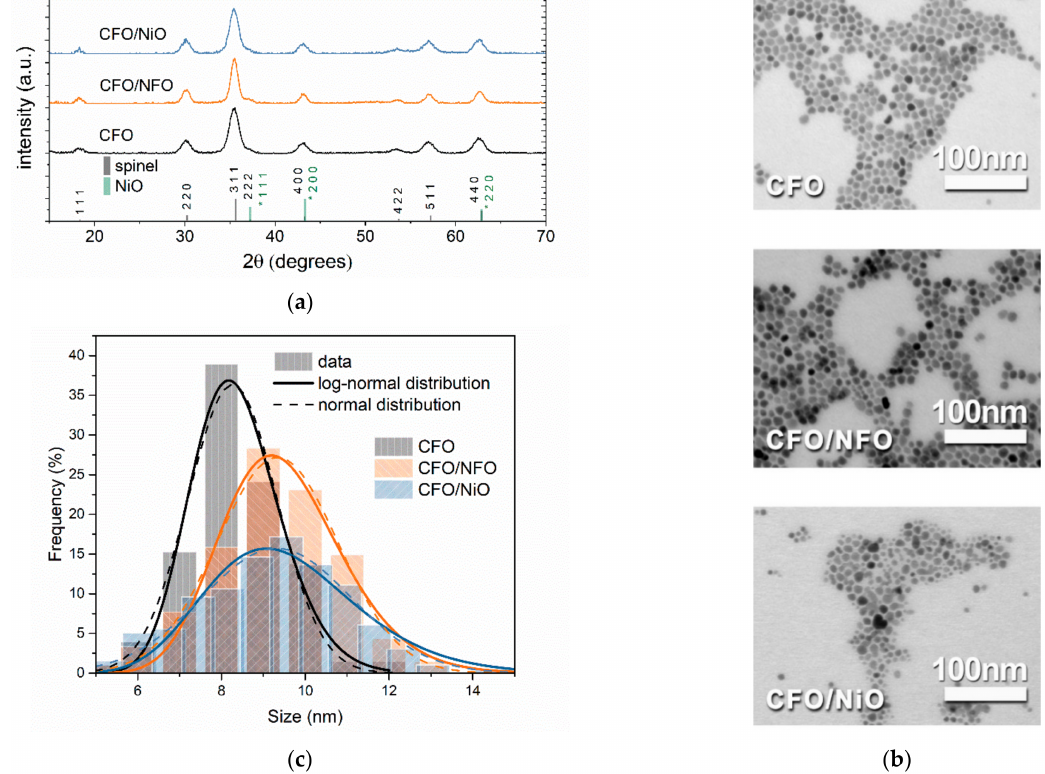
Figure 1. ( a ) XRD patterns and ( b ) STEM images for CFO seeds and core/shell systems; ( c ) diameter distribution obtained from STEM images.